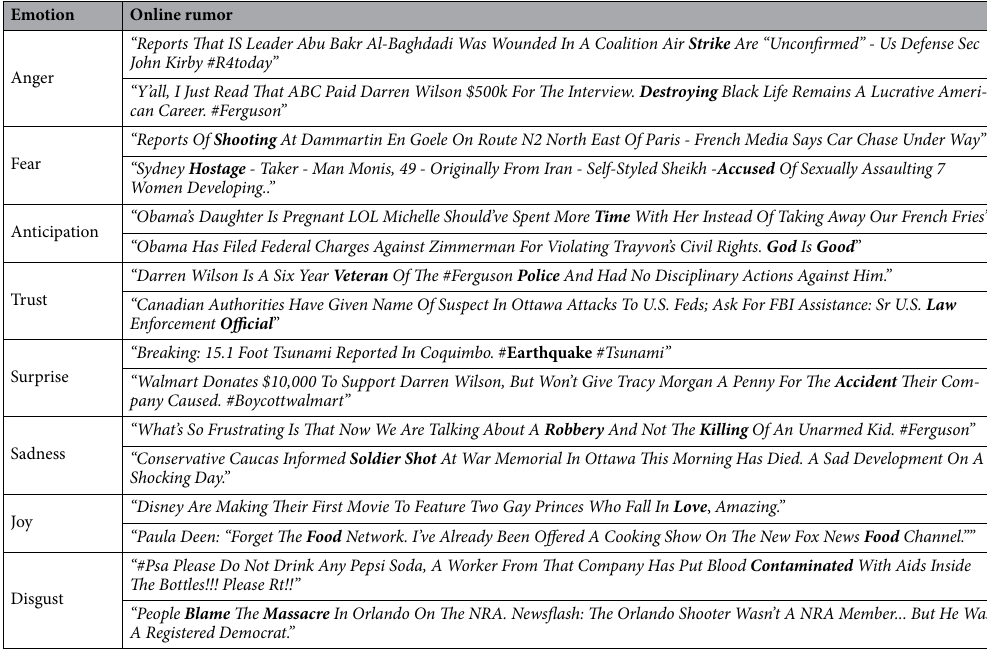
Table 2. Examples for rumors posted on Twitter and the emotional words they contain. The emotional words are classified according to the NRC emotion lexicon using eight basic emotions: anger, fear, anticipation, trust, surprise, sadness, joy, and disgust. Emotional word corresponding to the basic emotion in column